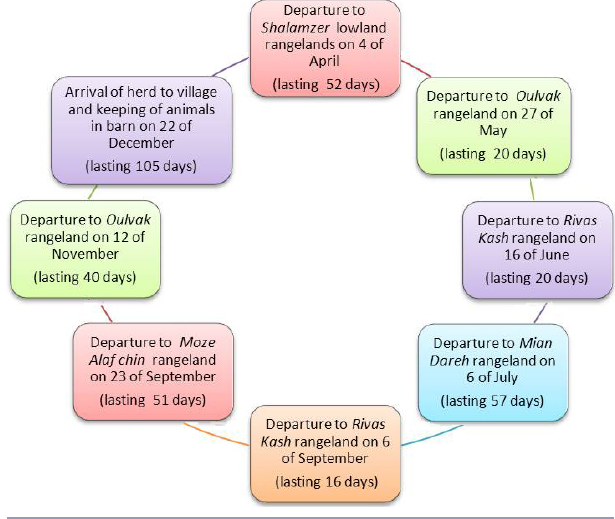
Fig. 3 . Herd management in the rangelands during 2011: herd no. 1. (In this herd, the shepherds use the Oulvak rangeland that is located next to Nariyan village (Fig. 2). This rangeland is shown on the map and is under the private ownership of one of Rafighs in this herd. Therefore the members of the herd pay a grazing fee to him when they use the